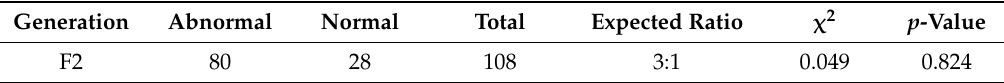
Table 1. Chi-square test for Mendelian segregation of abnormal brown film formation in F 2 generation. Generation Abnormal Normal Total Expected Ratio χ